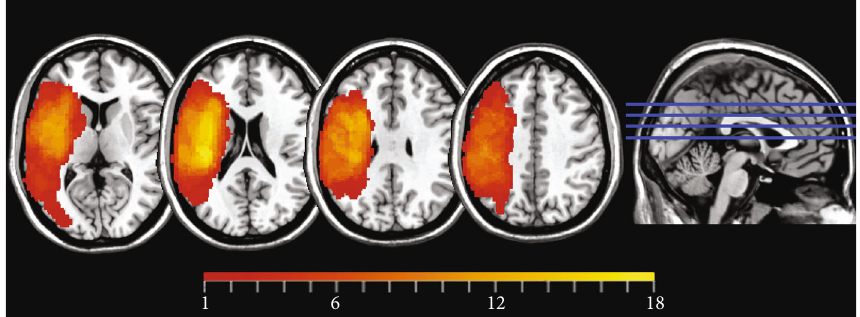
Figure 1: Lesion overlap of 20 PSA patients. The color bar represents the number of patients with a lesion in a speci fi c voxel (maximum 18 out of 20).